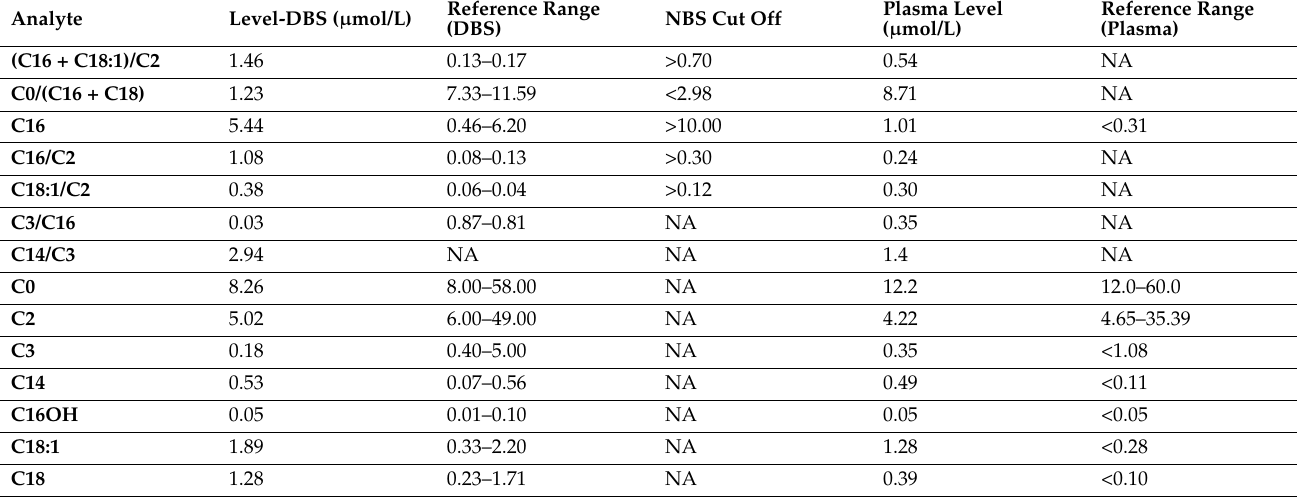
Table 1. Relevant free carnitine (C0) and acylcarnitine levels from newborn screening (NBS) dried blood spot (DBS) and initial plasma acylcarnitine